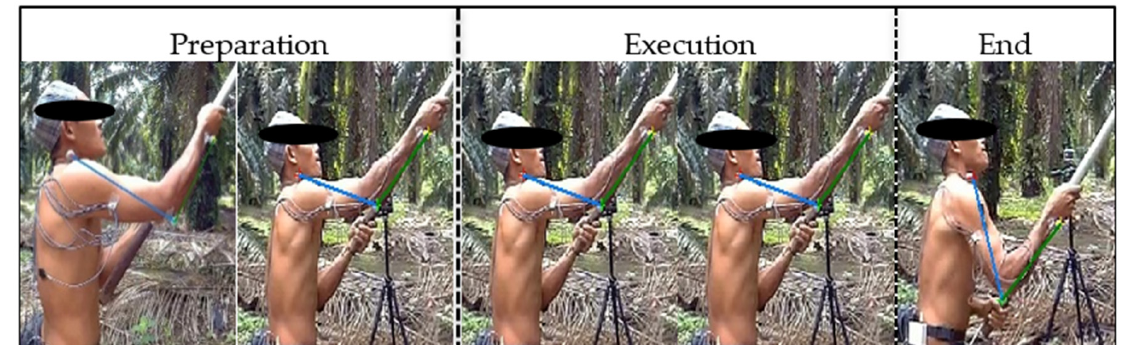
Figure 3. One cycle of push-pull-cutting movement.